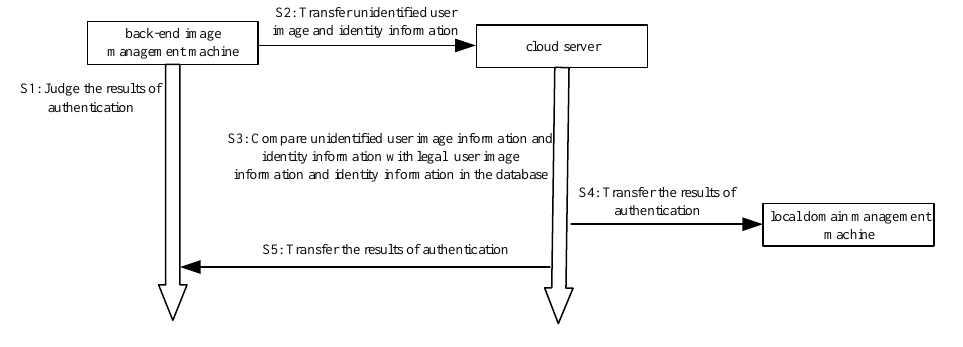
Figure 5. The authentication phase of the back-end image management machine and cloud server brief process diagram.